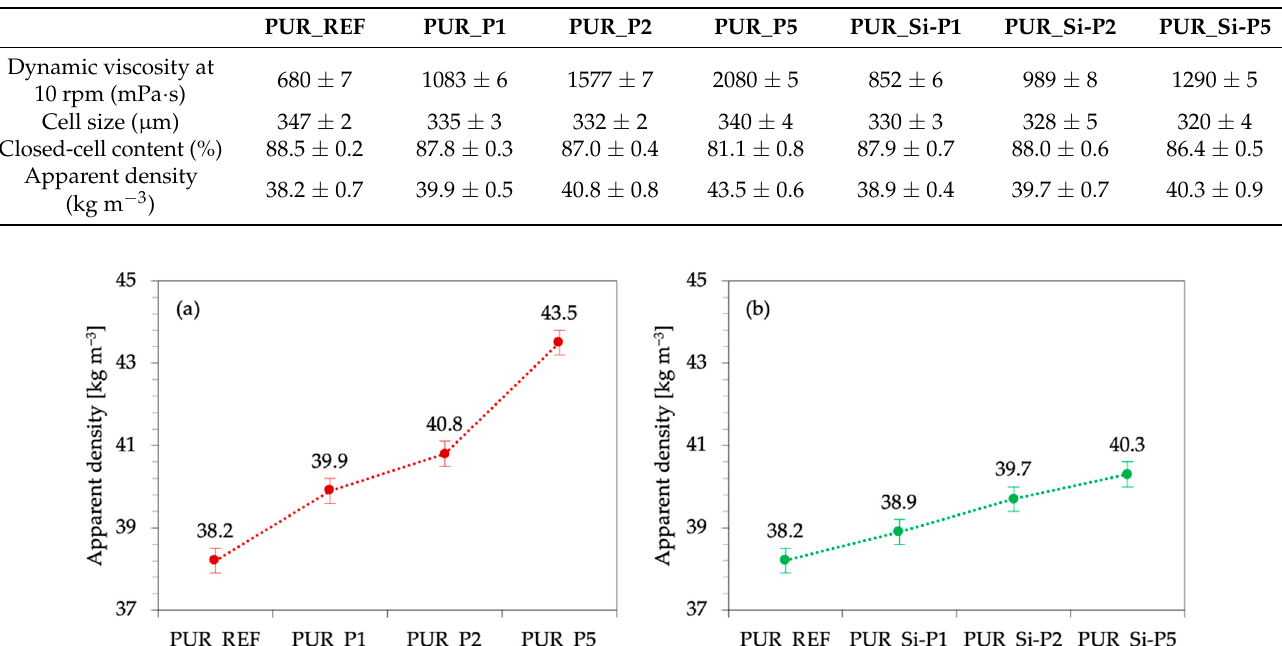
Figure 6. Results of apparent density determined for PUR composites modified with ( a ) plum filler and ( b ) silanized plum filler.